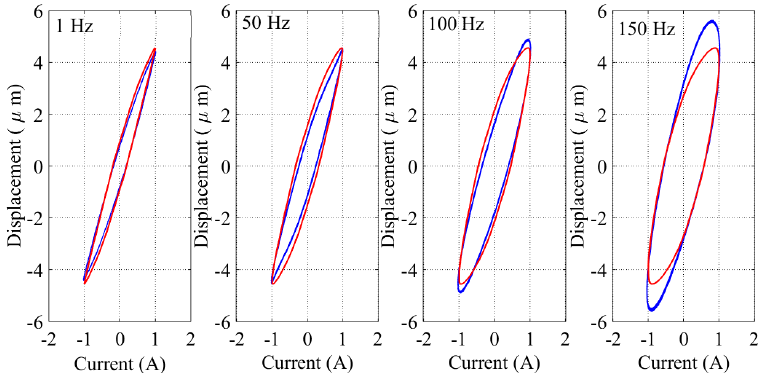
Figure 11. Comparisons of major-loop output-input responses between the proposed model and the measured data with load (21.5kg). (Frequencies in 1, 50, 100 and 150Hz and excitation amplitude 1A, blue line – measured data; red line – proposed model.)